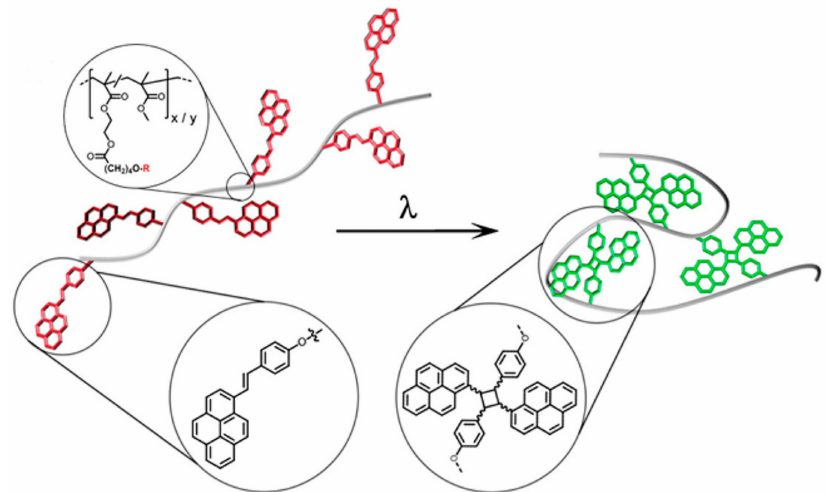
Figure 5. Schematic illustration of the enhanced reactivity of confined styrylpyrene moieties (shown in red color ) within single polymer chains allowing photoactivated SCNP formation at λ = 445 nm LED-irradiation within only 15 min via single chain folding induced by formation of styrylpyrene dimers (shown in green color ). Reprinted from [33] with